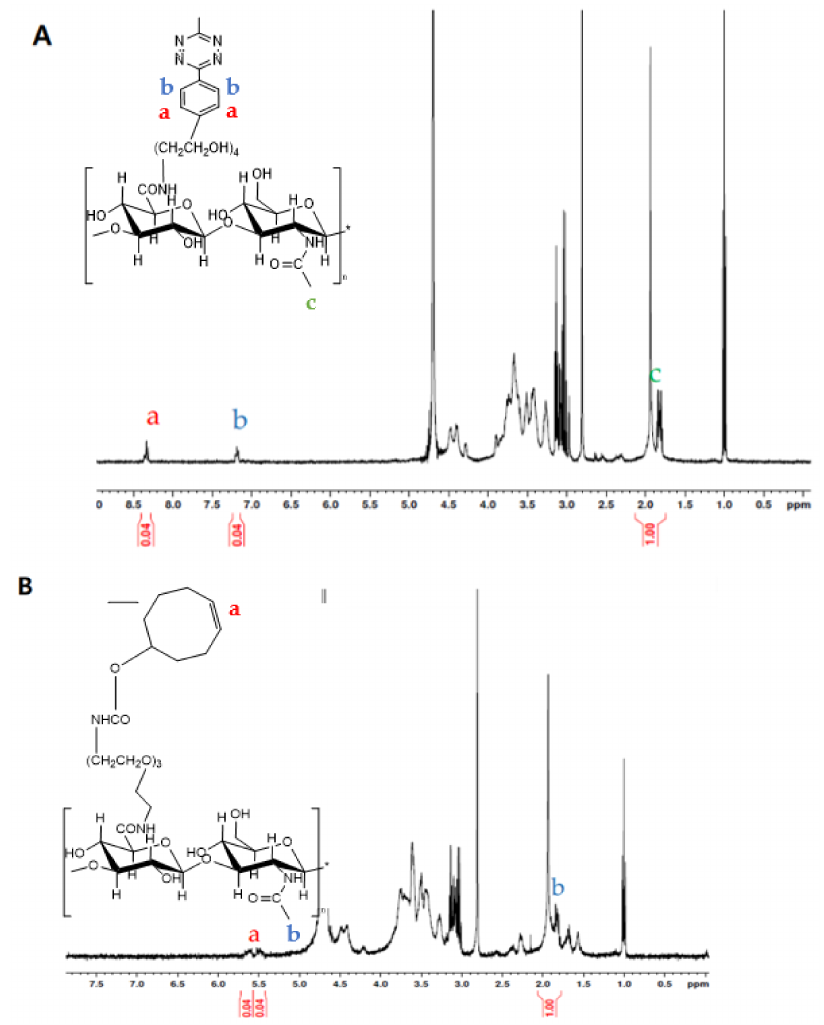
Figure 2. 1 H NMR spectra of ( A ) HA–Tz conjugates and ( B ) HA–TCO conjugates in D 2 O. Inset shows the molecular structure of each conjugate and the position of characteristic proton